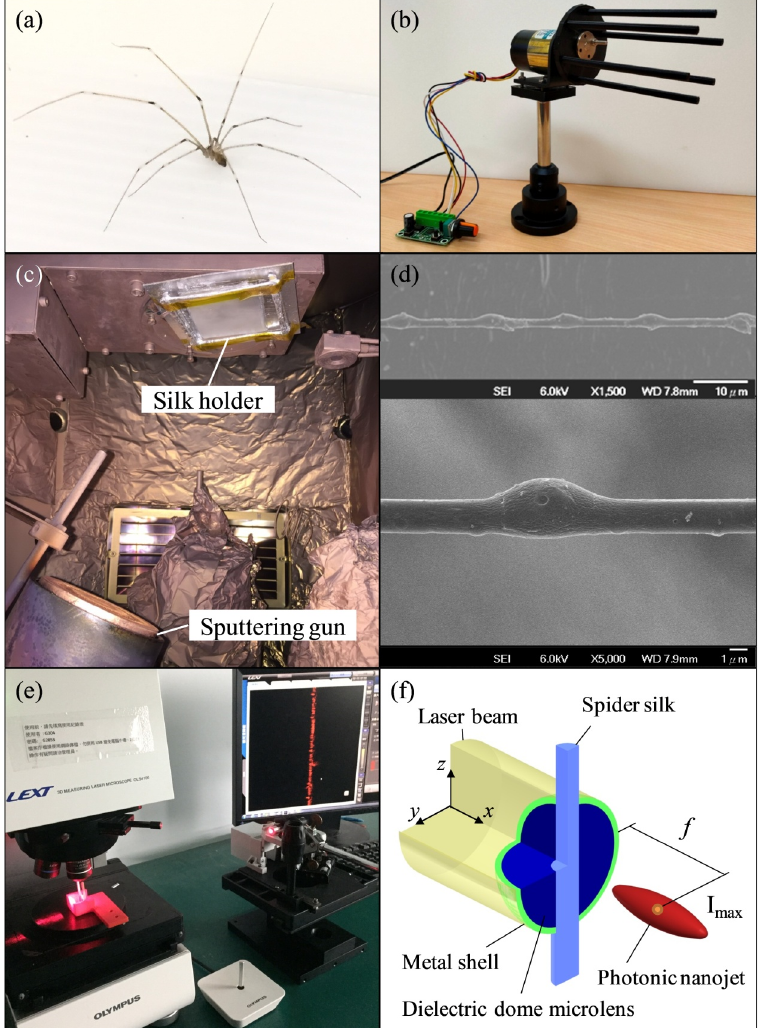
Figure 1. ( a ) A photo of a daddy long-legs spider. ( b ) The electric reeling system for the spider silk. ( c ) The sputtering manufacturing process for coating the spider-silk-based metal–dielectric dome microlens. ( d ) An SEM image of the dome microlens. ( e ) The laser scanning digital microscope system for measuring the dome microlens. ( f ) A schematic diagram of the dome microlens for photonic nanojet modulation.